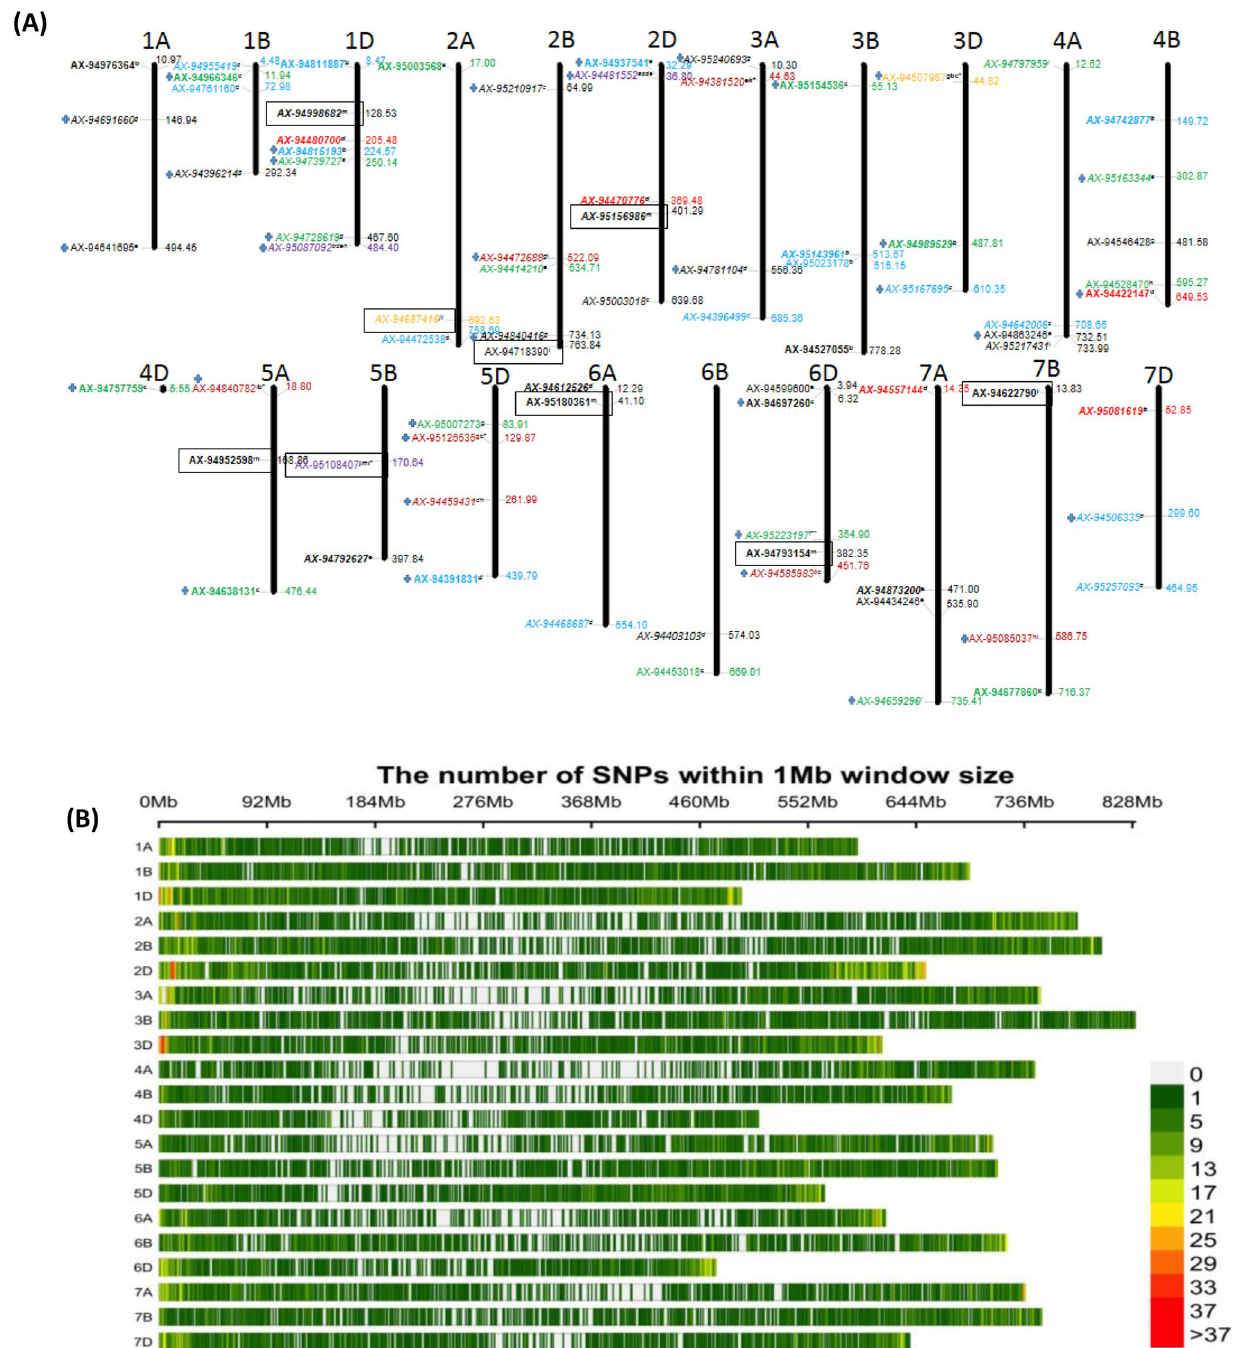
Figure 7. (A) Chromosomal localization of SNP markers on 21 chromosomes of wheat. The chromosome numbers are indicated on top of chromosomes. On each chromosome, the marker names are indicated on the right side and their physical positions are indicated on the left side. Markers without a box: identified under soil; markers within a box: identified under hydroponics; a-m: different traits (a-GPP, b-GPU, c-GWP, d-PUE, e-PHI, f-PAE, g-SPP, h-SPU, i-TBM, j-TPU, k-PSSI, l-SDW and m-PCON); normal font: markers under sufficient P; Bold font: markers under low P; Italic font: markers for which genes identified, markers with *: available in sufficient P and low P. Different colours indicate markers in different situations and for different traits: Blue: 2016; Green: 2017, Red: 2016 and pooled data (2016 + 2017); Purple, Orange, Maroon and Black: markers identified for more than four, three, two and one trait. Markers with blue plus sign passed Bonferroni Correction. (B) SNP density plot chromosome wise representing number of SNPs within 1 Mb window size. The horizontal axis shows the chromosome length (Mb); the different color depicts SNP